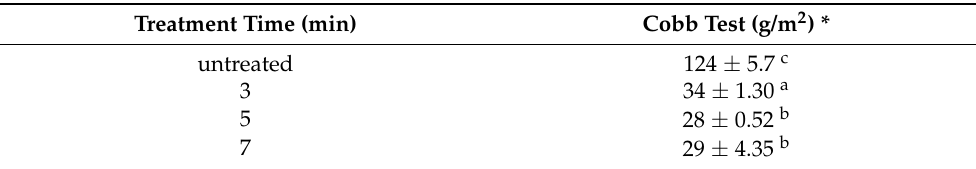
Table 4. Effect of treatment time on Cobb test of untreated and treated KPs with plasma at 200 mTorr and 50 Watts.